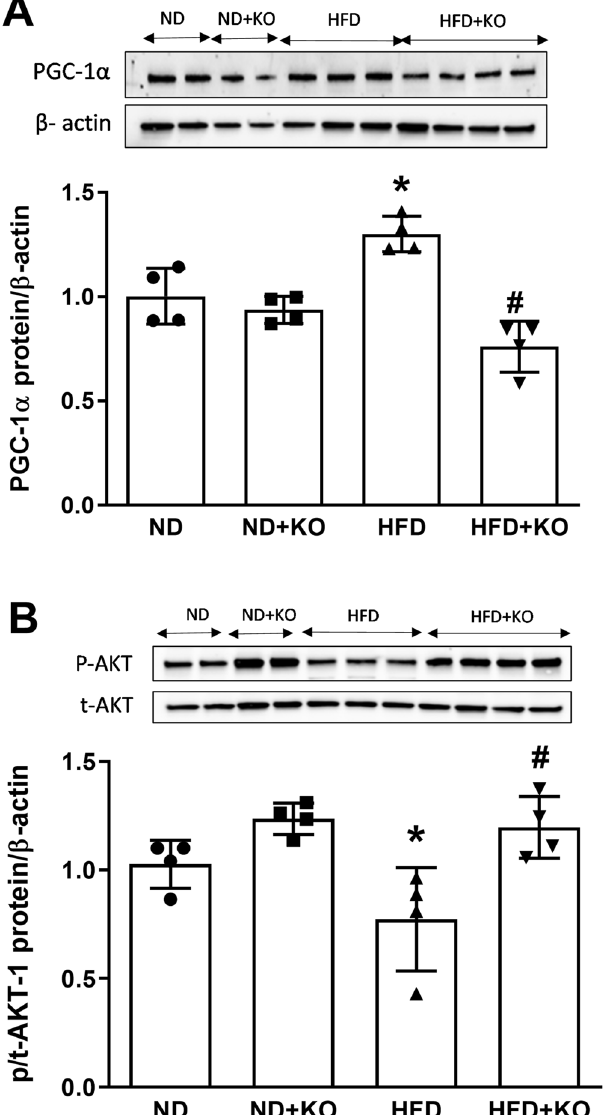
Figure 7. Renal cortical expression of PGC-1α and p/t-AKT-1. Renal cortical protein expression of PGC-1 α and p/t-AKT-1 after 8 weeks following normal diet (ND) and high fat diet (HFD) in mice with or without Atp6ap2-KO. Data presented as mean ± SEM, * P < 0.05 versus HFD; # P < 0.05 versus HFD + KO, n = 3–5 each